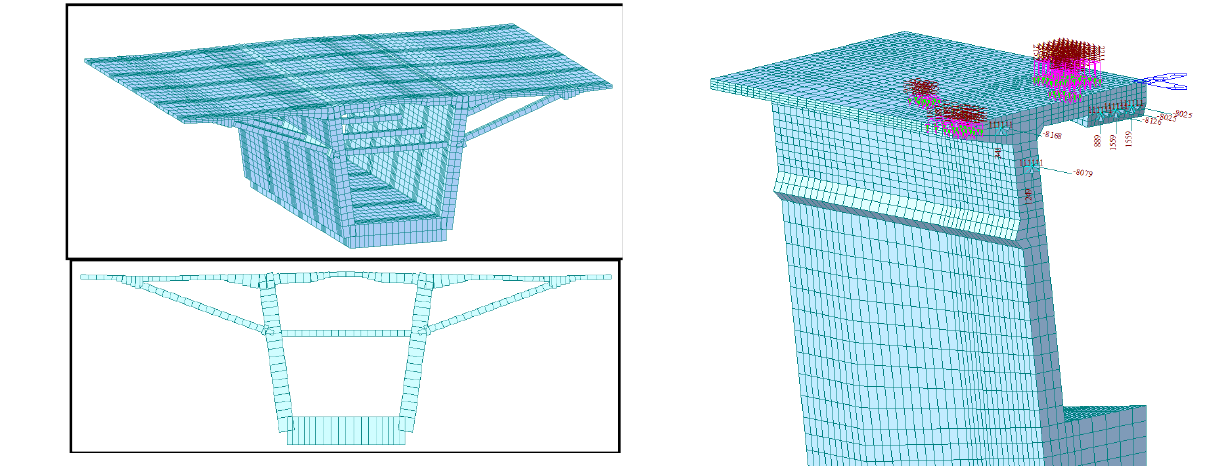
Figure 6. Shell element model.